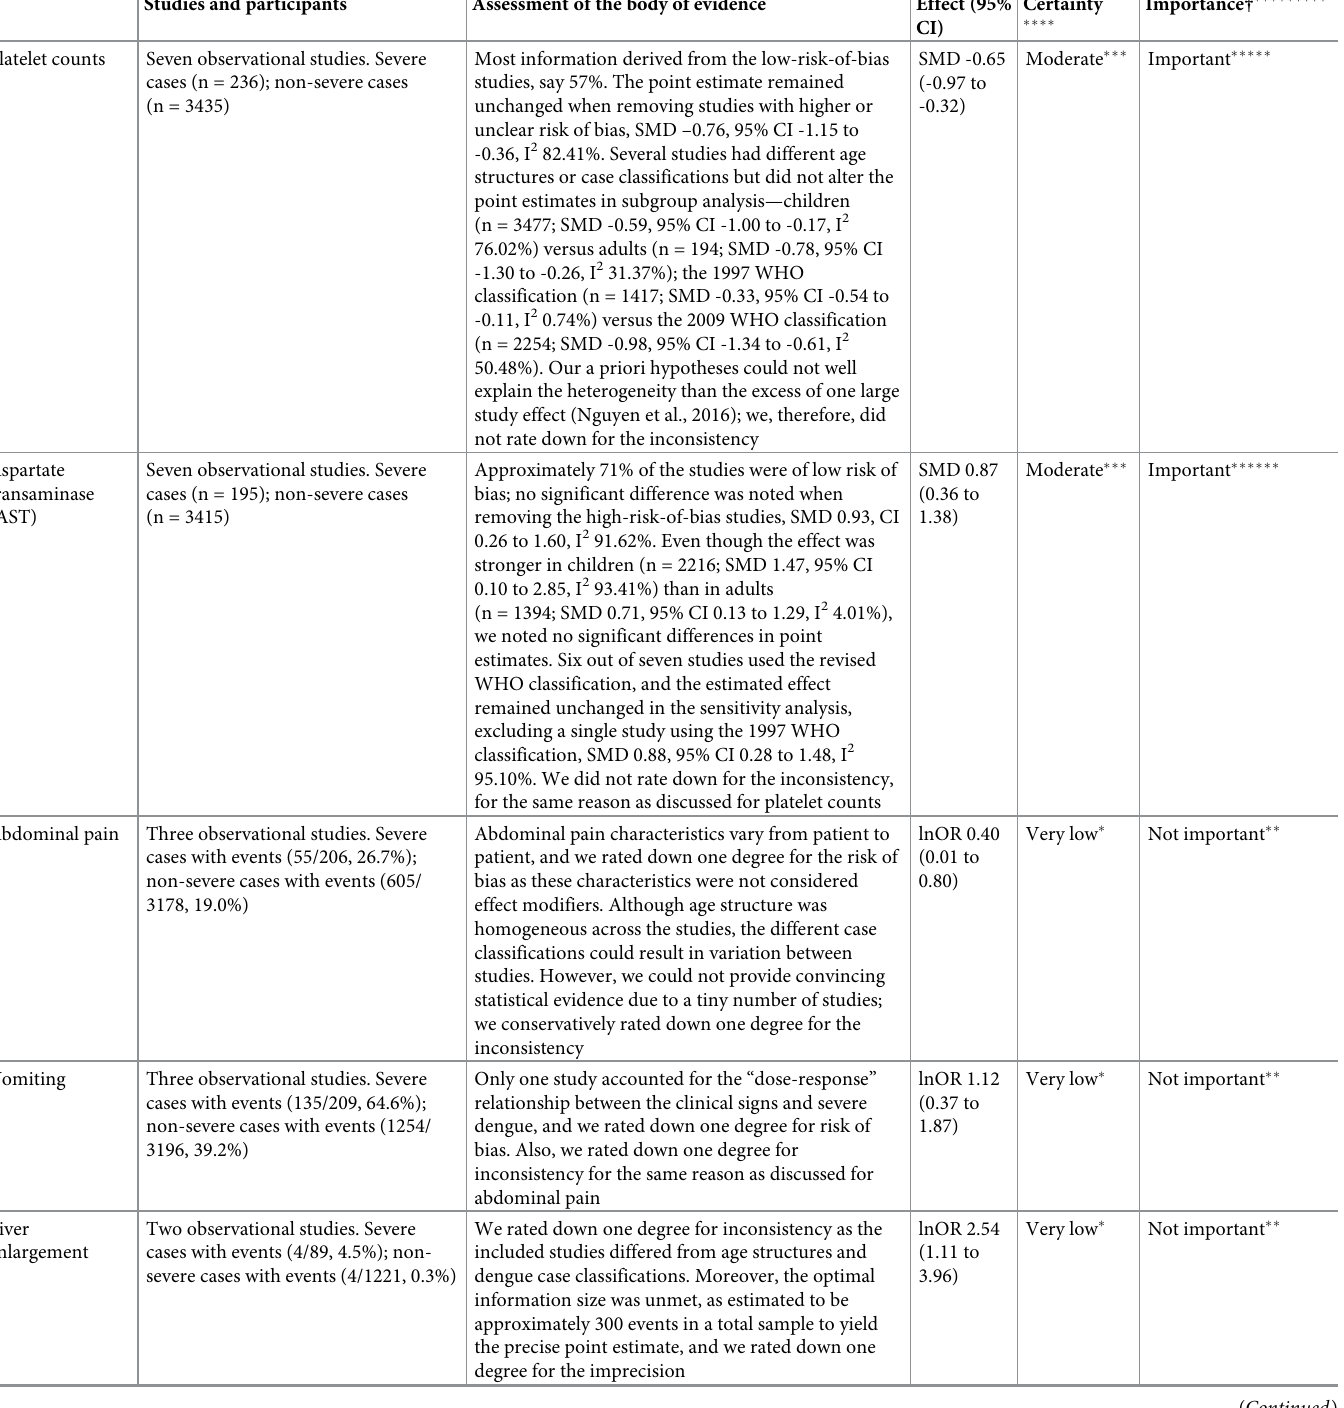
Table 2. GRADE evidence